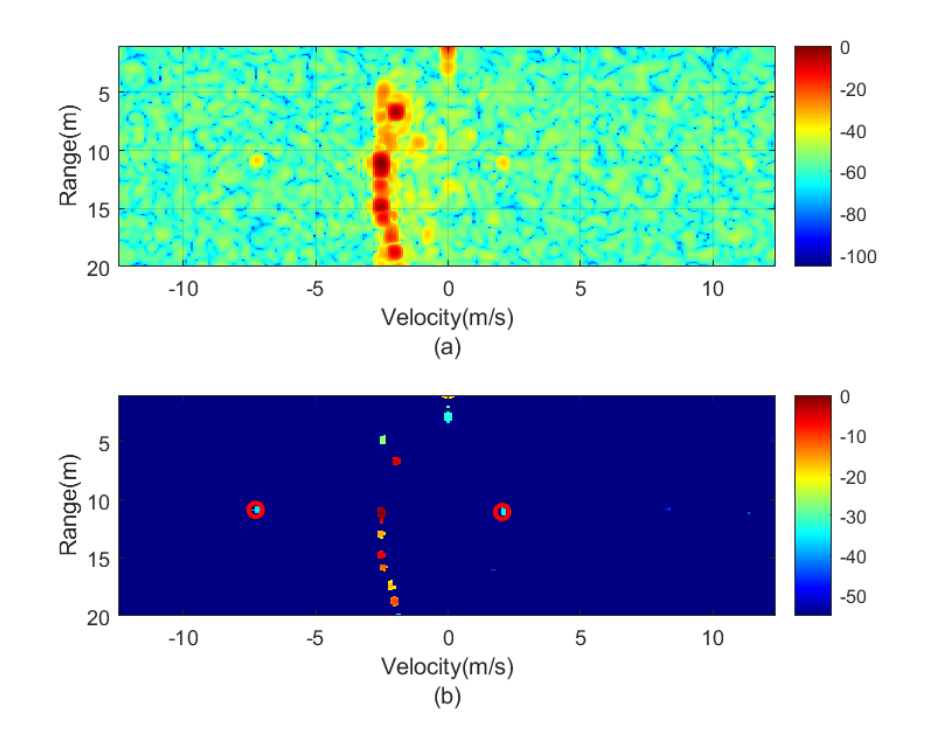
Figure 11. Measured range—Doppler map ( a ) and detection after CFAR processor ( b ) for the transponder modulated at 750